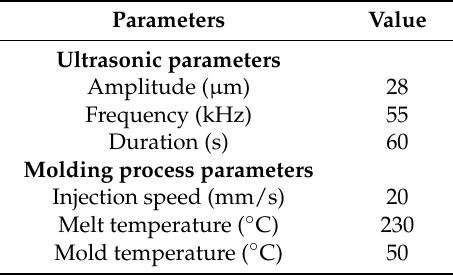
Figure 2. The model of the microneedle array part. Table 1. Parameters in the numerical simulation.